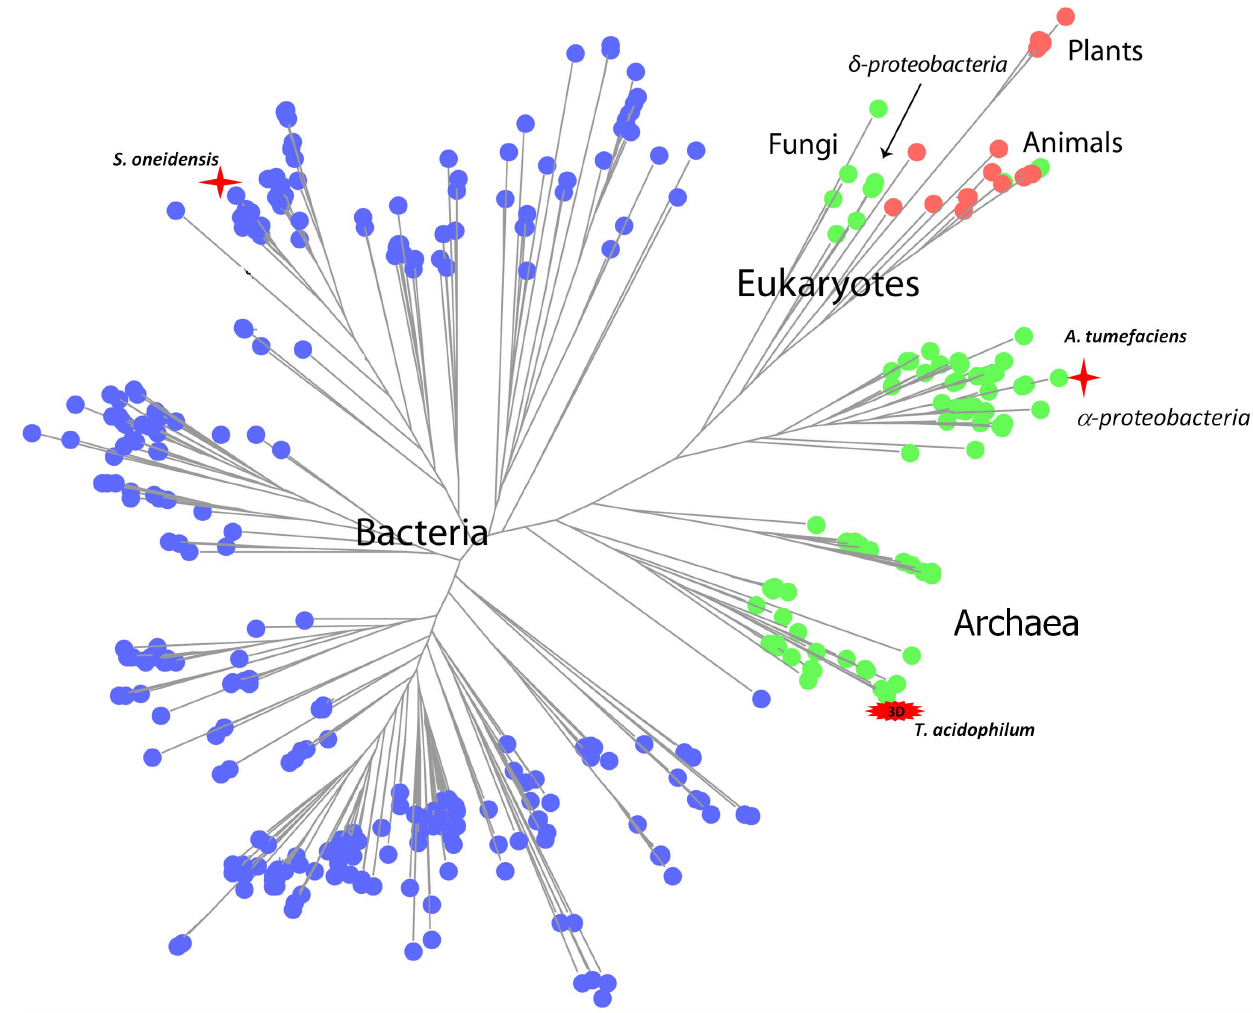
Figure 7. Phylogenetic tree of COG1058. Schematic representation of the COG1058 phylogenetic tree (full version is in Fig. S1). The stand-alone COG1058 gene and the gene fused with FAD synthetase and pncC genes are depicted as green, red and blue circles, respectively. The Shewanella oneidensis and Agrobacterium tumefaciens COG1058 proteins, experimentally characterized in this work, are marked by red stars. Thermoplasma acidophilum COG1058 protein, whose 3D structure is available, is highlighted.